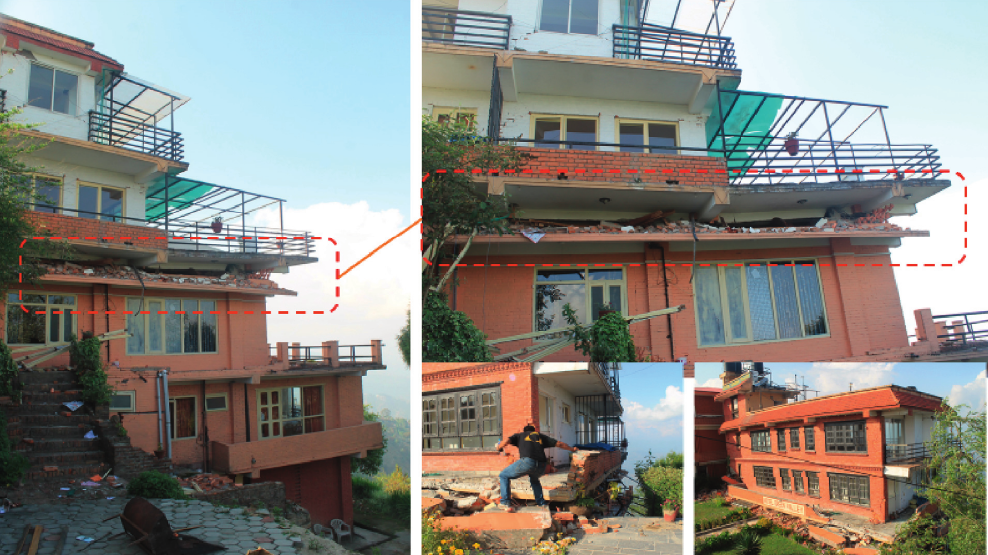
Figure 4: Intermediate story collapse in a modern hotel building compliant to the prevalent code at Nagarkot, Bhaktapur,